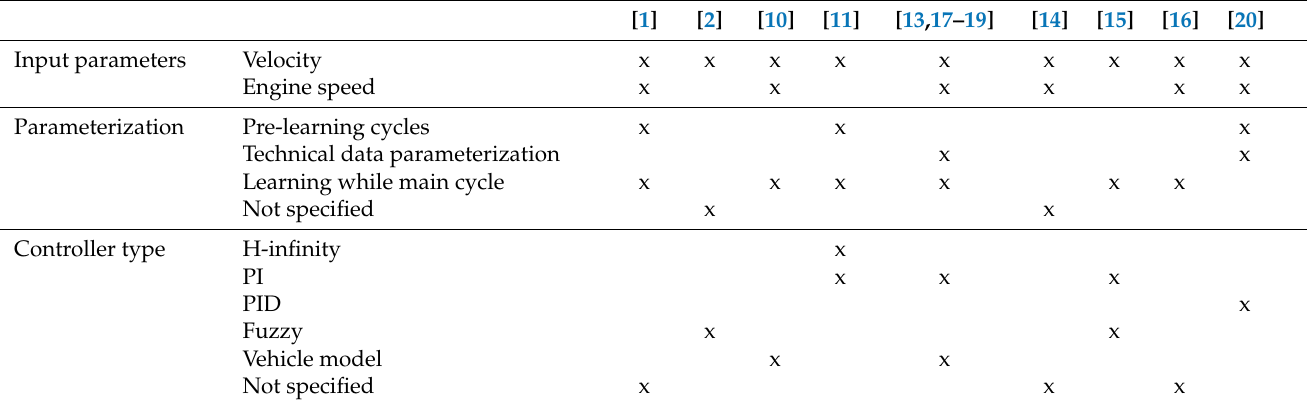
Table 2. Pedal robot control methods, required input parameters, and types of parameterization used by different